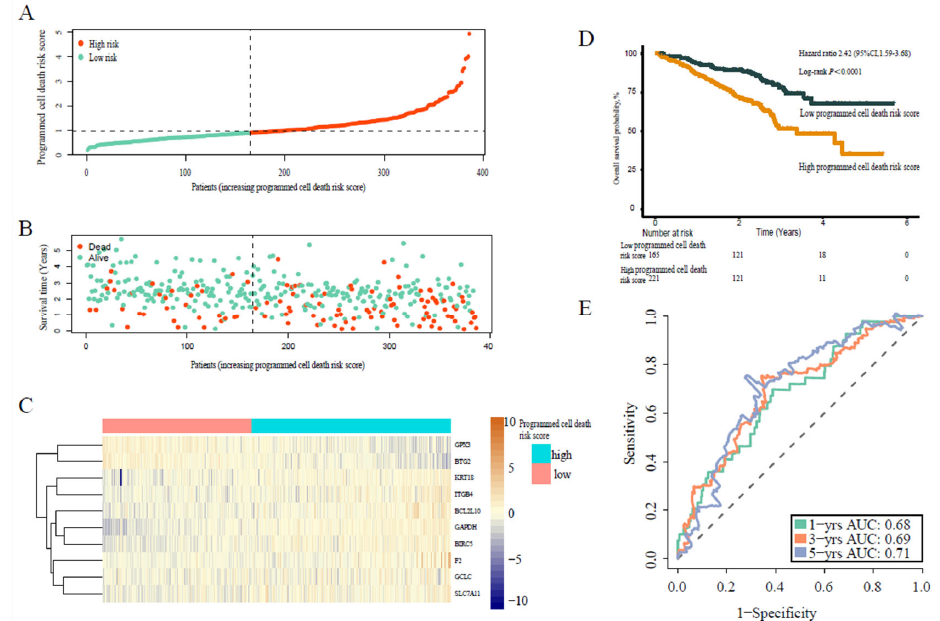
Figure 3. Prognostic analysis of programmed cell death risk score in validation cohort 1. ( A ) Distri- bution of programmed cell death risk scores in validation cohort 1. ( B ) Patterns of the survival time and survival status of the patients based on programmed cell death risk scores. ( C ) Heatmaps of the ten prognostic genes for each patient of the training cohort. ( D ) Kaplan–Meier survival curve of the patients according to the programmed cell death risk scores. ( E ) Time-related ROC analysis showing the prognostic performance of the programmed cell death risk score formula in validation cohort 1.